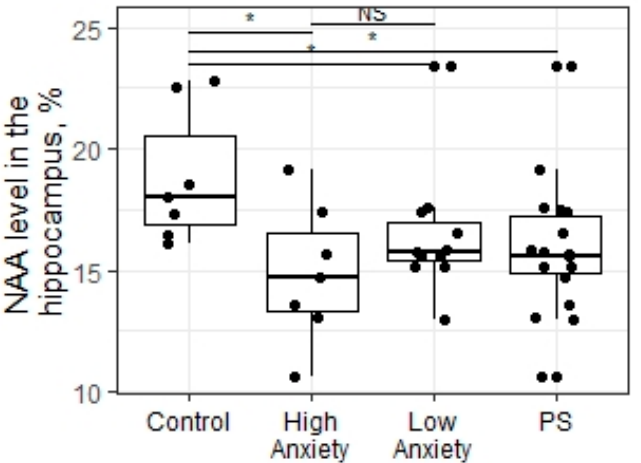
Figure 6. NAA level (%) in the hippocampus of PSS rats segregated into high- and low-anxiety groups according to AI as determined by performance in the EPM. Differences in NAA levels among groups are shown as boxplots with dots representing individual data values and medians shown by horizontal lines. The boxes include the central 50% of the data, i.e., from the 25th to the 75th percentile. The whiskers include the data contained within 1.5 times the interquartile range. NS—non-significant, p > 0.05; * p < 0.05. p values were determined in non-parametric